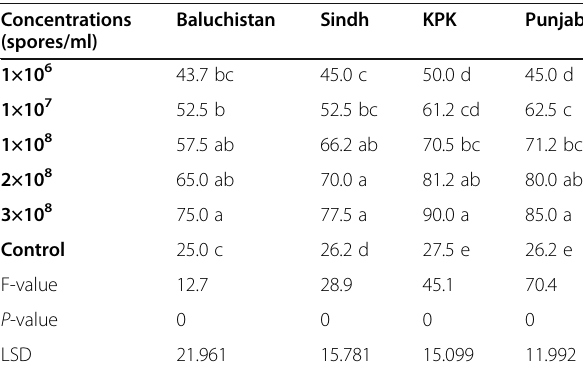
Table 4 Percent mortalities of Rhynchophorus ferrugineus on the 7th day after treatment with Beauveria